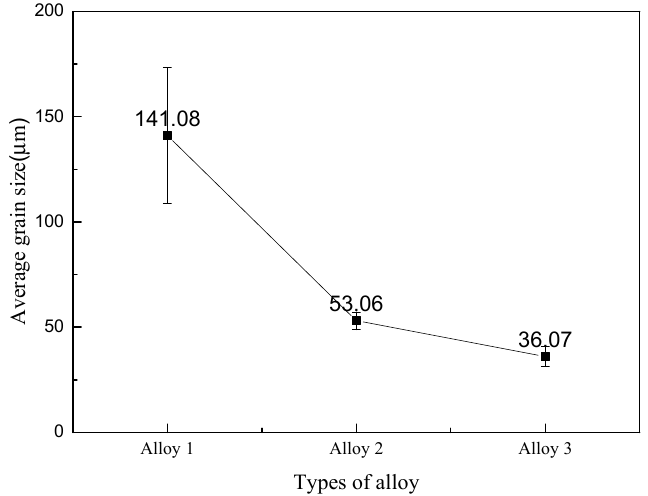
Figure 4. The average grain size of as-cast Al-Mg alloys with different compositions.